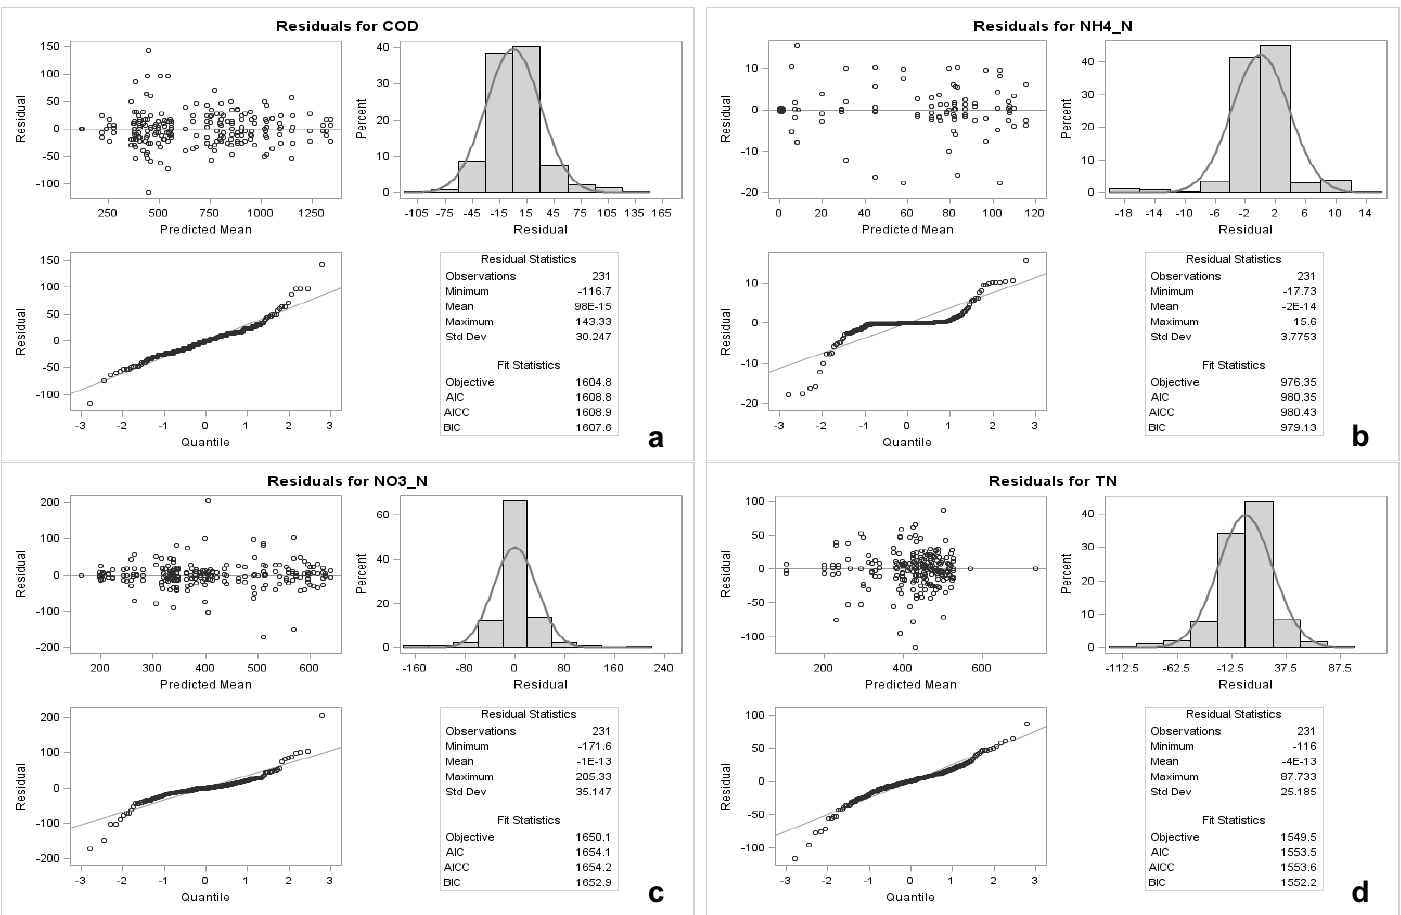
Figure A1 . Diagnostic plots for the linear mixed effect model with ( a ) COD, ( b ) NH 4+ -N, ( c ) NO 3 − -N and ( d ) TN as response variable and time and treatment as fixed effects. The compound symmetry covariance structure was used to account for variations in compound concentration across time for each treatment